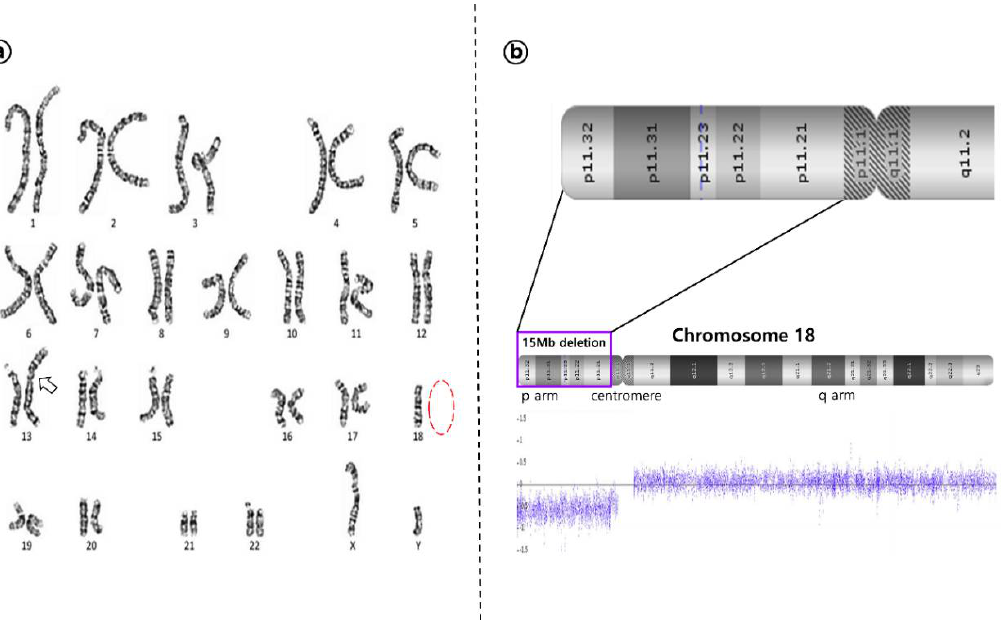
Figure 2. Cytogenetic results. ( a ) The karyotype of proband: 45, XY, der(13;18) (q10;q10), indicating unbalanced translocation between the long arm of one chromosome 13 and the long arm of one chromosome 18 (white arrow); ( b ) array-based comparative genomic hybridization (aCGH) of proband revealed as 15 Mb deletion in the short arm from 18p11.32 to p11.21.